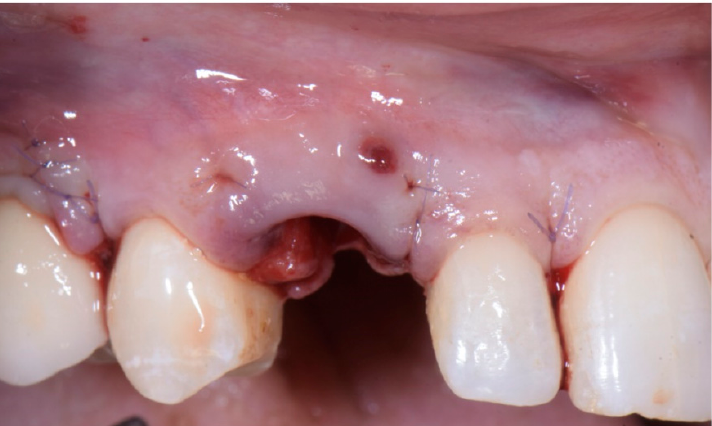
Figure 10. Initial suture of the weakest papilla (the mesial one) before placing the provisional crown, obtaining an ideal adaptation of the surgical papilla on top of the smaller anatomical papilla.